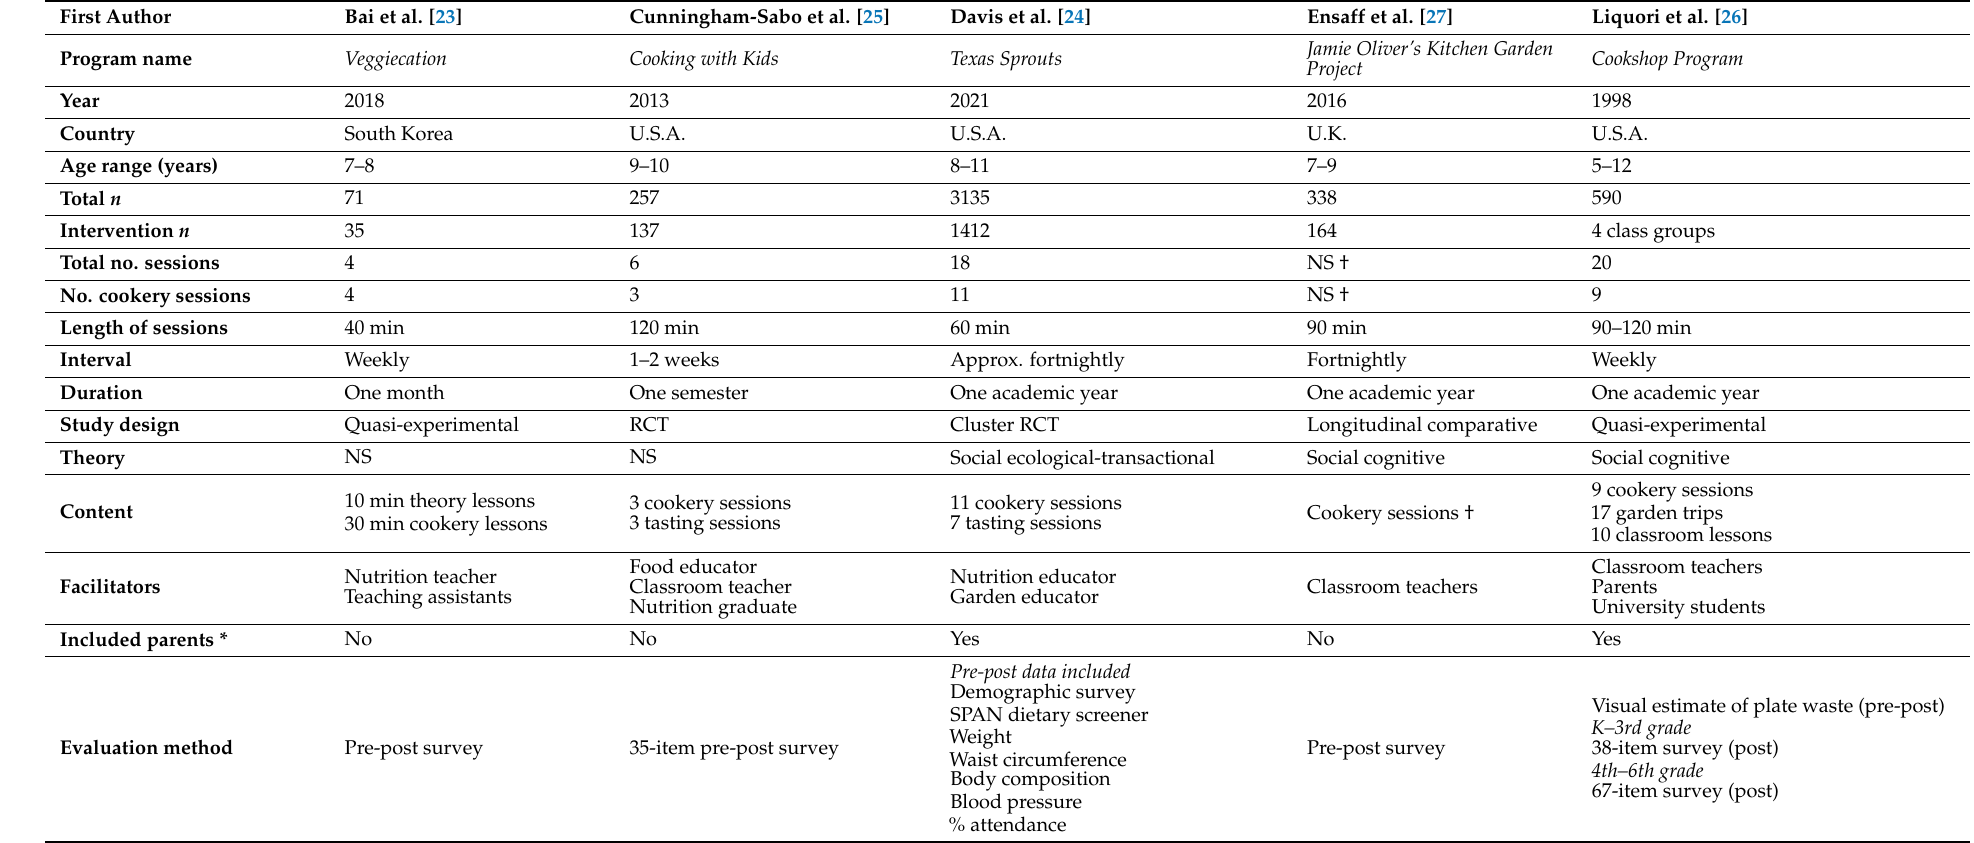
Table 1. Characteristics of school-based culinary interventions for 5–12-year-old